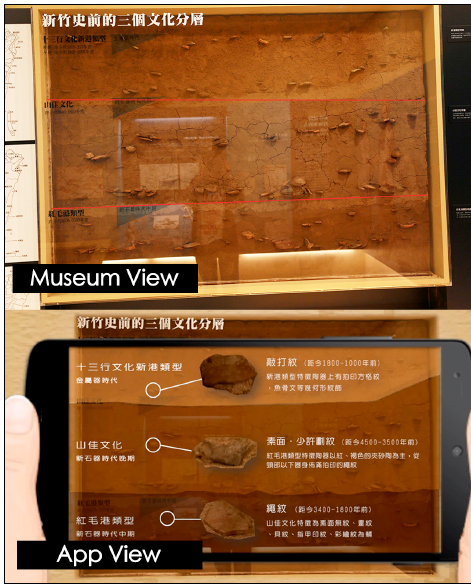
Figure 7. The original exhibition item (above) and the further information showing on the device after scanned